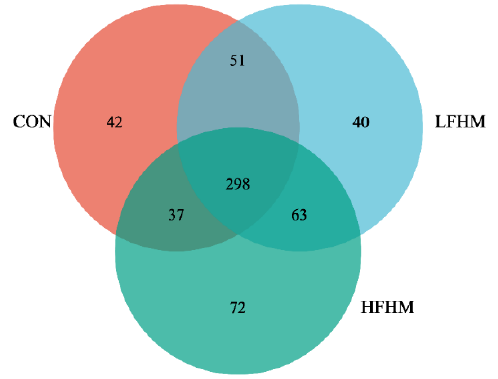
Figure 2. Relative abundance of fecal bacteria based on the genus level. Different color areas in the figure indicate the proportions of different species. Among them, species with an abundance less than 1% are combined as other. The relative abundance of colon microbial genus (mean of each group). CON, control group; LFHM, low fermented herbal medicine; HFHM, high fermented herbal medicine.